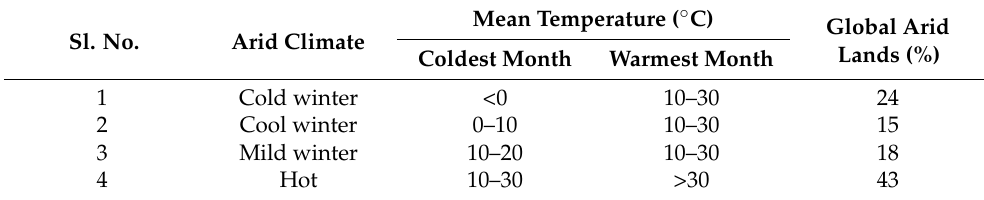
Lands (%)Coldest Month Warmest Month